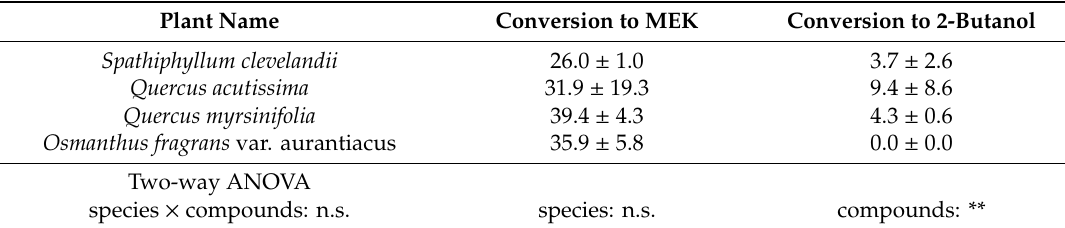
Table 1. Conversion ratios of MVK to methyl ethyl ketone (MEK) and to 2-butanol.